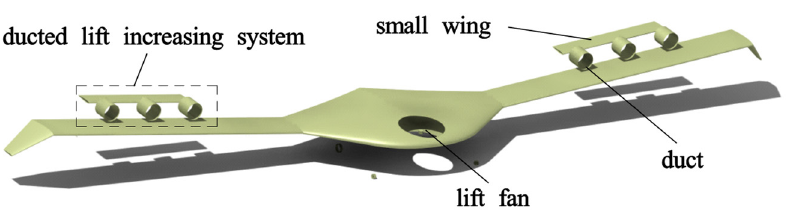
Figure 1. Conceptual graphs of vertical take-off and landing fixed-wing UAV, which includes a lift fan and ducted lift-increasing system.